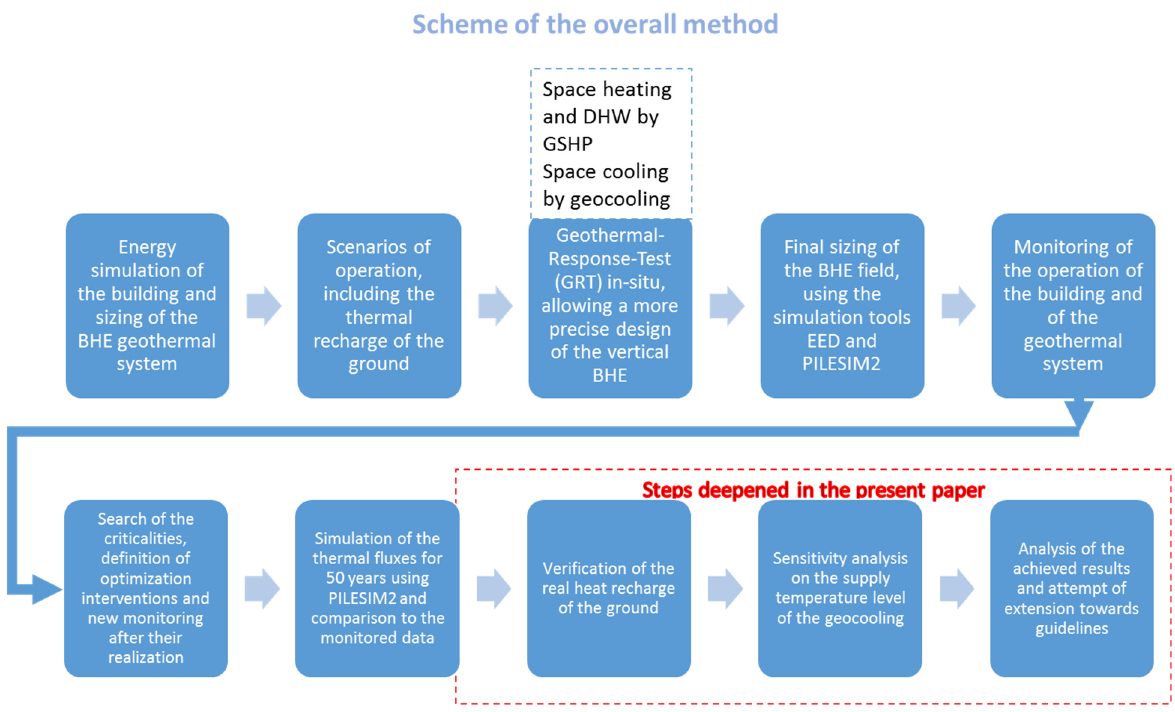
Figure 1. Scheme of the overall